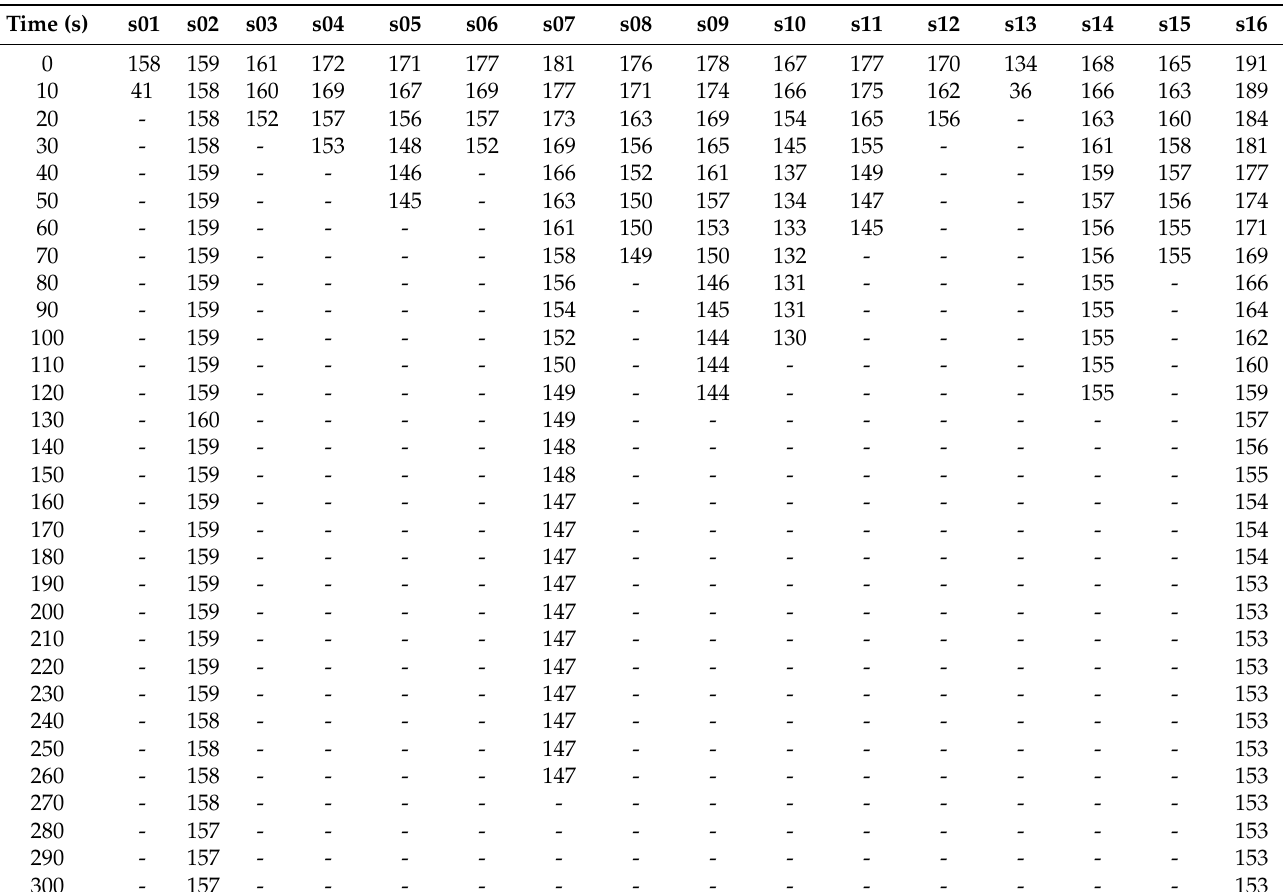
Table 2. The distance of foam head surface (mm) from the top of the table for 16 beer samples.